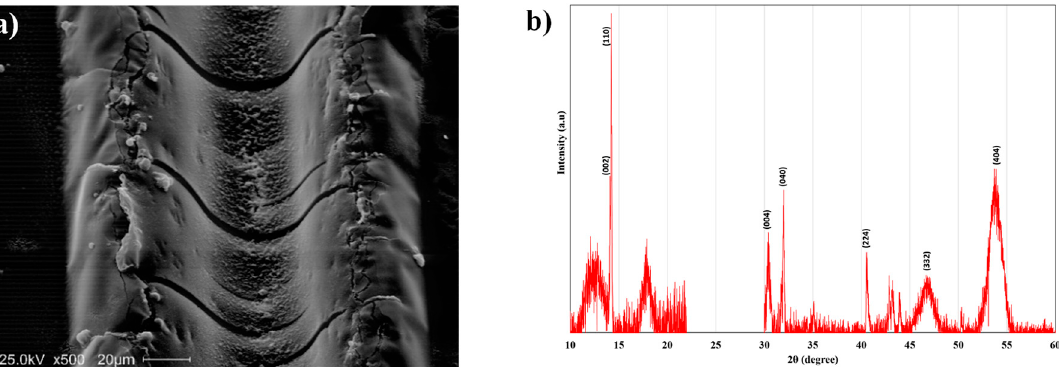
Figure 2. ( a ) The SEM image of the laser engraved microchannel (the image is taken at 44 degrees tilt angle), ( b ) the XRD spectra of the perovskite channel.